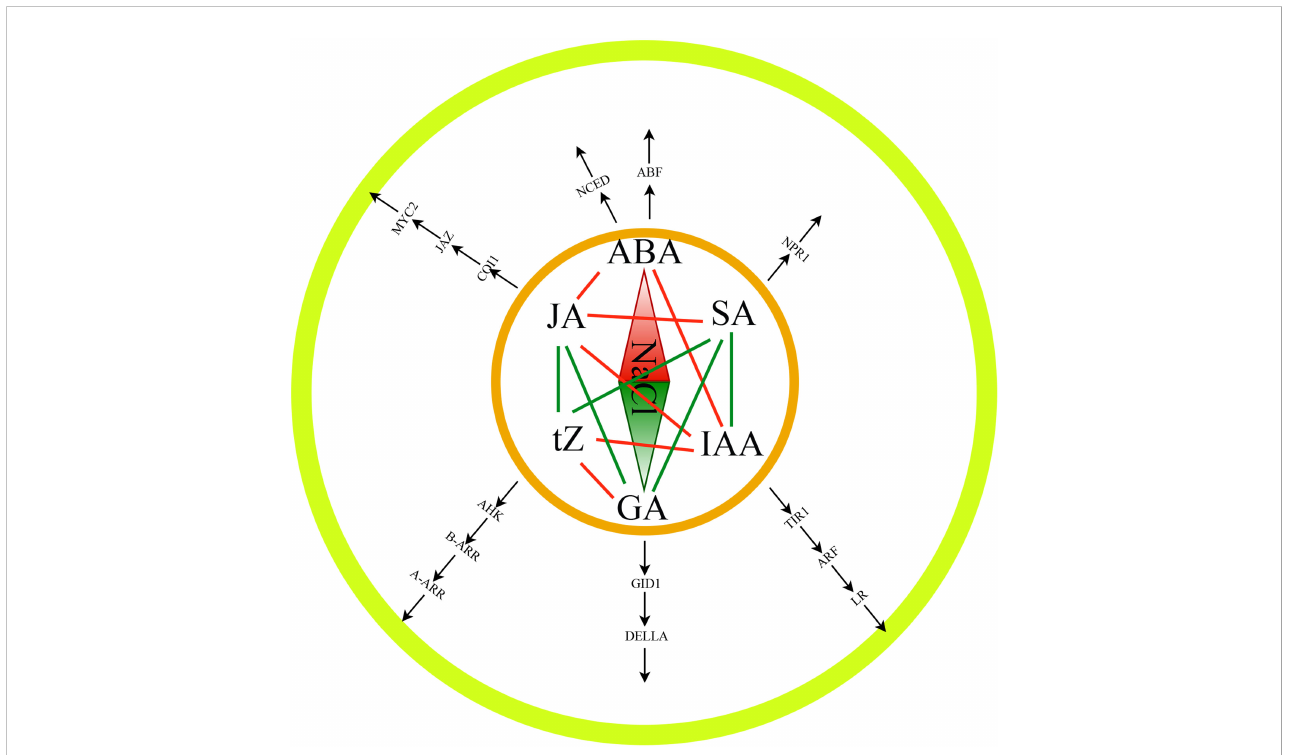
FIGURE 8 The plant hormone-mediated salt tolerance of tomato